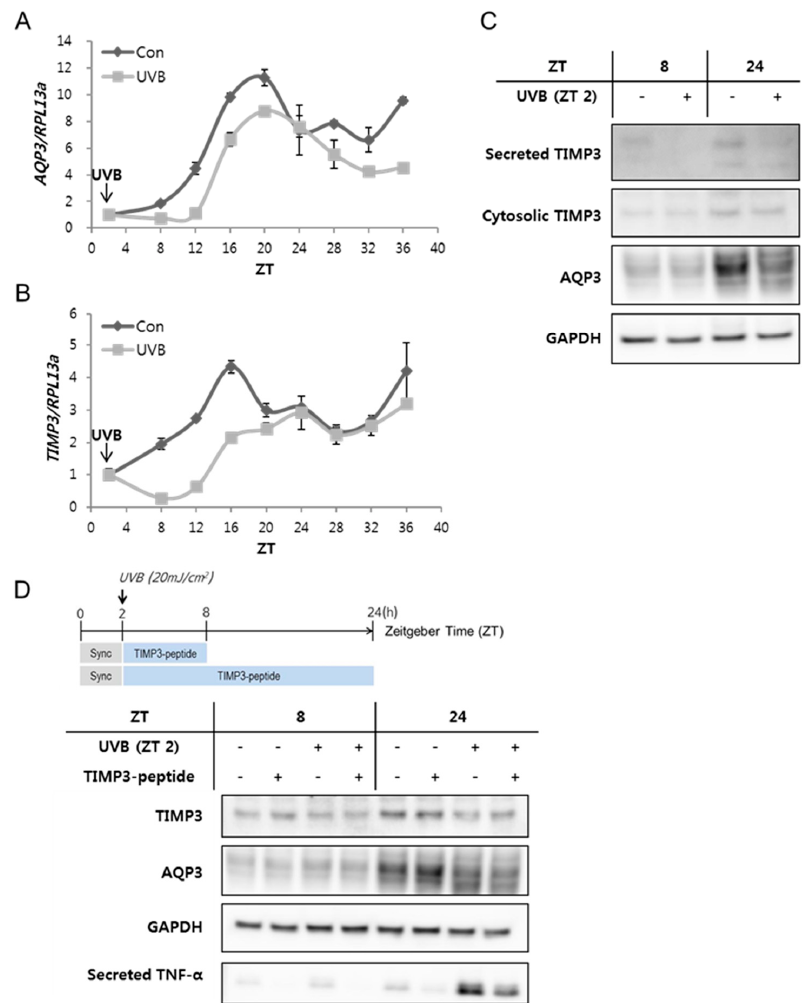
Figure 2. Expression of AQP3 and TIMP3 and the effect of synthetic metalloproteinase inhibitor 3 (TIMP3) peptides on tumor necrosis factor- α (TNF- α ) secretion in ultraviolet B (UVB)-irradiation conditions. NHEKs were treated with 20 mJ/cm 2 UVB at zeitgeber time (ZT) 2 and harvested every 4 h. The expression of AQP3 ( A ) and TIMP3 ( B ) was downregulated by UVB irradiation but recovered at ZT 24; ( C ) The secreted or cytosolic TIMP3 and aquaporin 3 (AQP3) were examined at ZT 8 and 24 after UVB irradiation. UVB irradiation reduced the protein levels of both TIMP3 and AQP3. Glyceraldehyde 3-phosphate dehydrogenase (GAPDH) was loaded as the control; ( D ) Synthetic TIMP3-peptides were used to treat the cells with or without UVB irradiation (Figure 3). TIMP3, AQP3, and the secreted TNF- α protein levels were analyzed using Western blotting at ZT 8 and 24. The synthetic TIMP3-peptides inhibited UVB-induced TNF- α secretion. GAPDH was loaded as control. Sync indicates